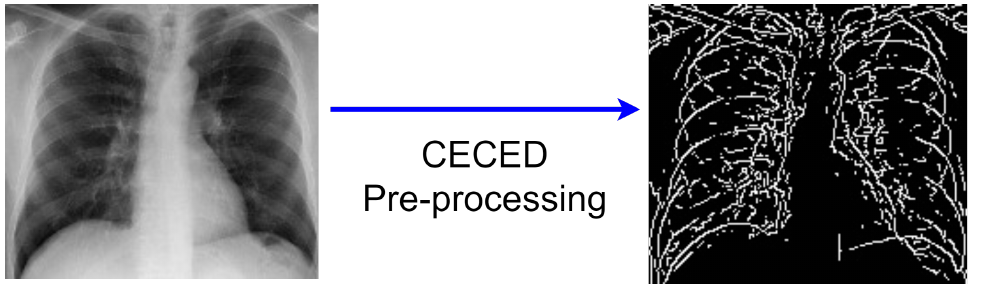
Figure 4. CECED Pre-processing.